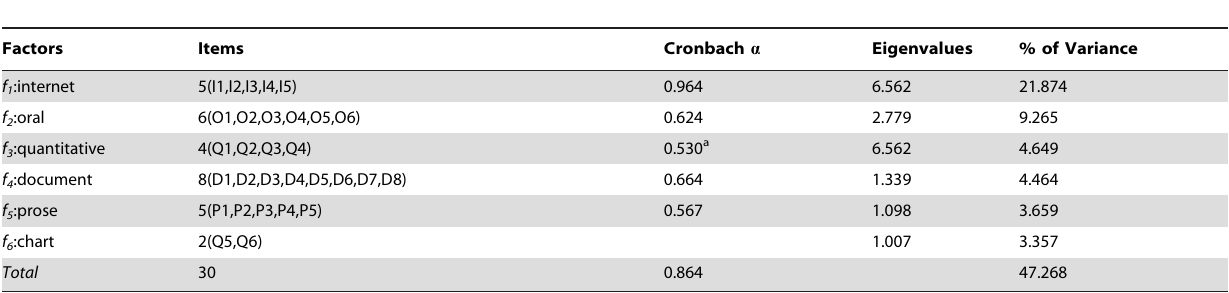
Table 3. Reliability and construct validity of the instrument on health literacy regarding infectious respiratory diseases.